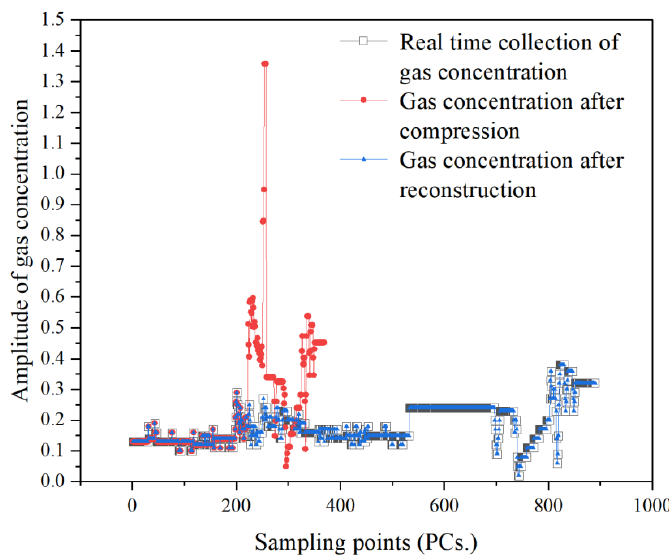
Figure 12. The self-derived compression and reconstruction result. Table 4. Changes in the Amount of Huffman Coding Information after all-level decomposition (Kb).